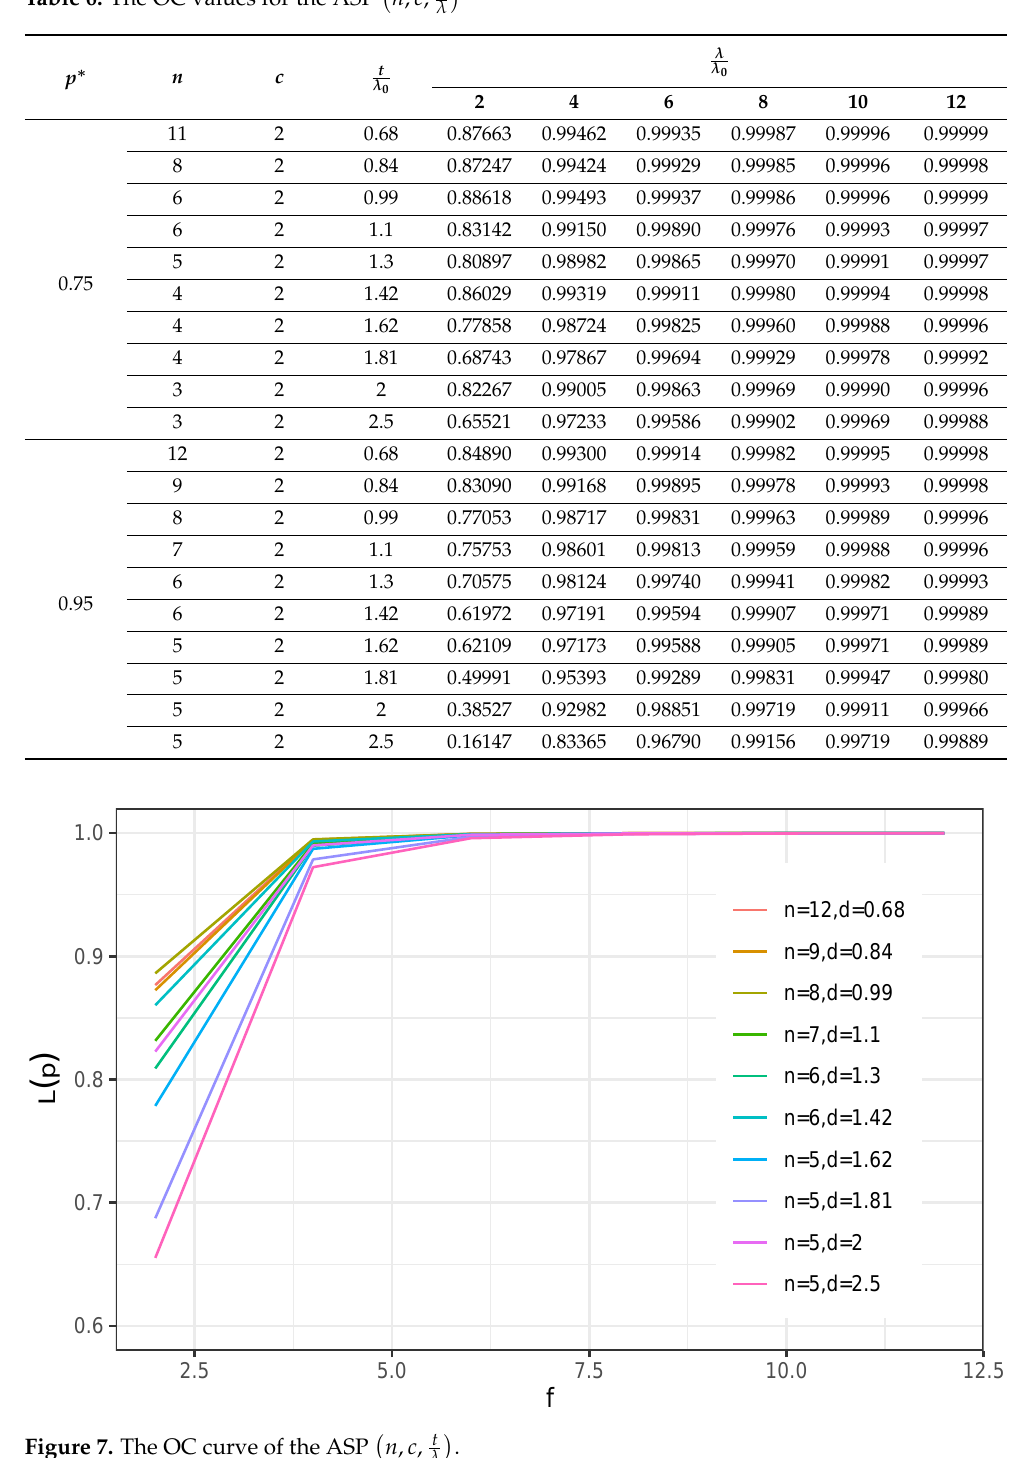
Table 6. The OC values for the ASP